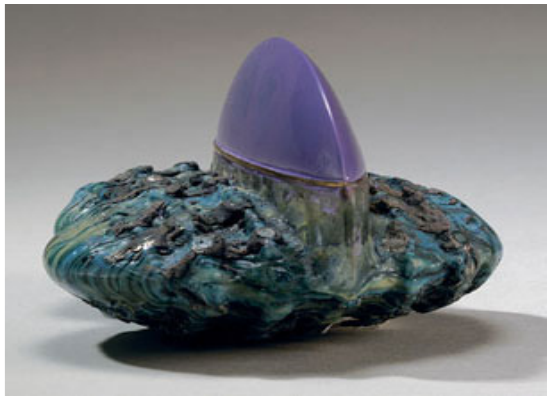
Figure 6. Keith Cummings; Crest , 2002; cast bronze applied to wax model, wax steamed out and glass cast into mould with pre-cast and polished kiln-formed glass element; courtesy of the artist, used with